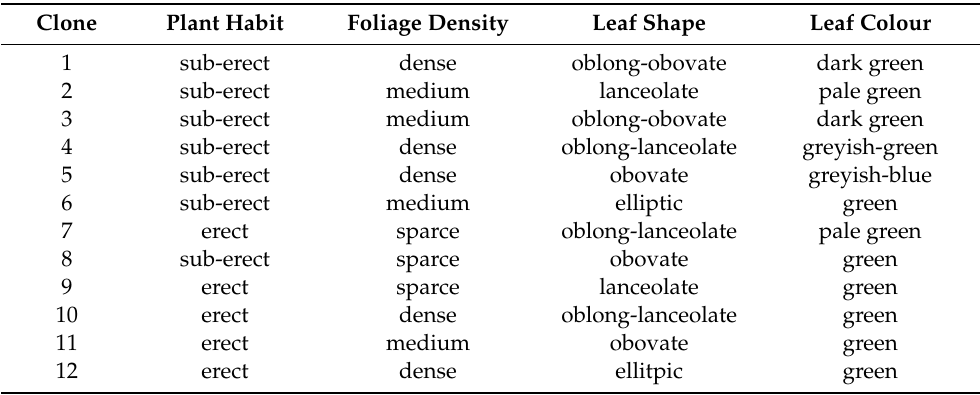
Table 2. Morphological traits of investigated